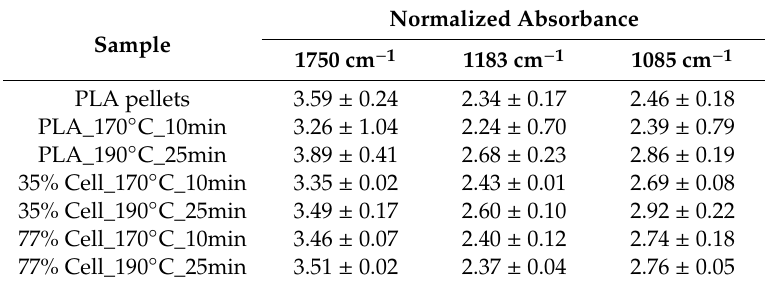
Table 3. Average normalized absorbance values, measured in correspondence to the specific wavelengths, normalized with respect to the peak at 1455 cm -1 for the tested specimens.